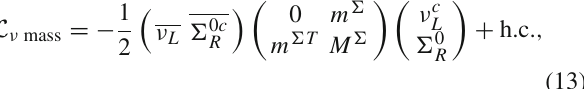
Table1 SMEFTWilsoncoefficientsobtainedfrommatchingtheType- I and Type-III Seesaw models at the scale μ = M X [78–80]. In order to properly account for the stringent bounds from the non-observation of Coefficient Type-I